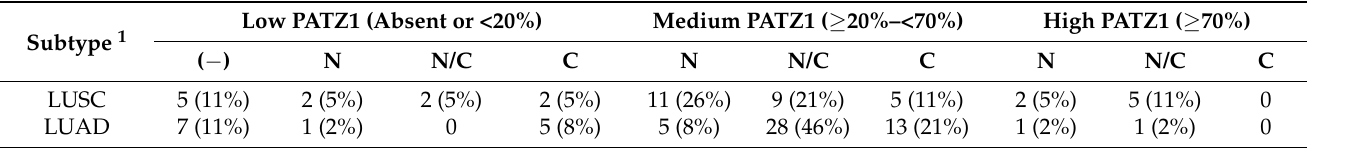
Table 4. PATZ1 expression groups based on the percentage of stained